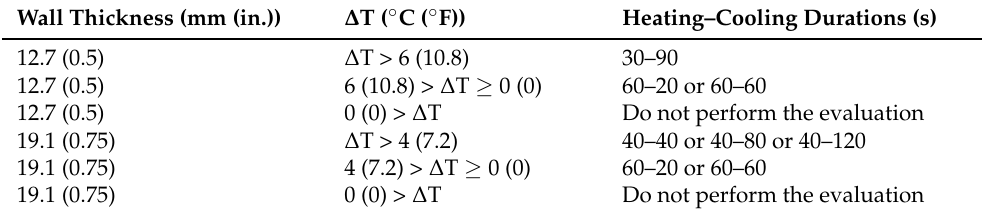
Table 8. Guideline for selecting the heating–cooling durations. Wall Thickness (mm